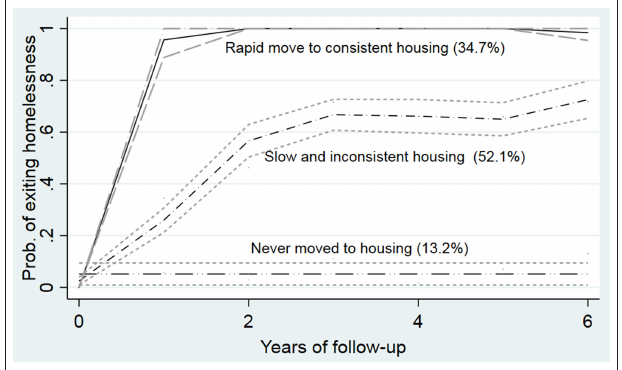
FIGURE 1 | Housing trajectory groups over time points with 95% confidence